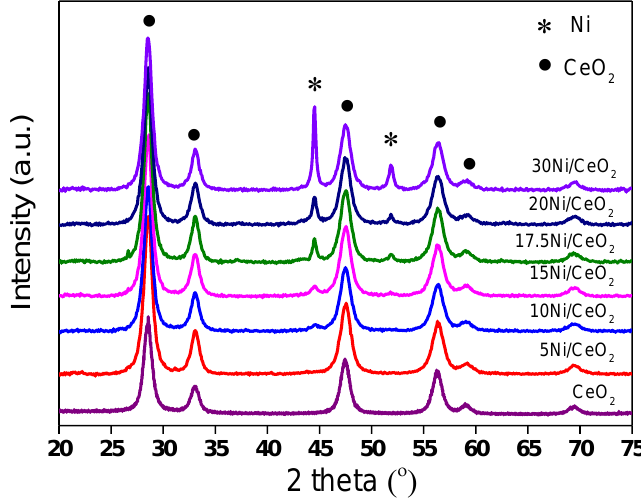
Figure 2. The XRD patterns of reduced xNi/CeO 2 catalysts.